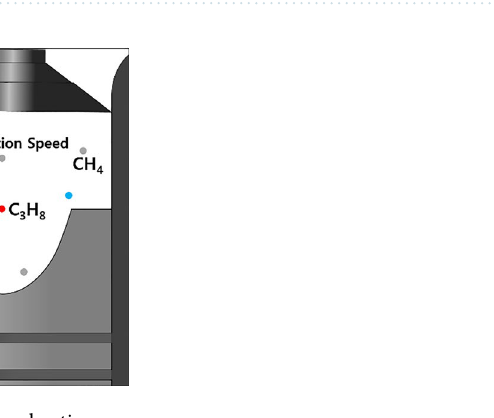
Figure 8. Variation in the cylinder pressure and normalized rate of heat release with the C 3 H 8 mixture ratio.